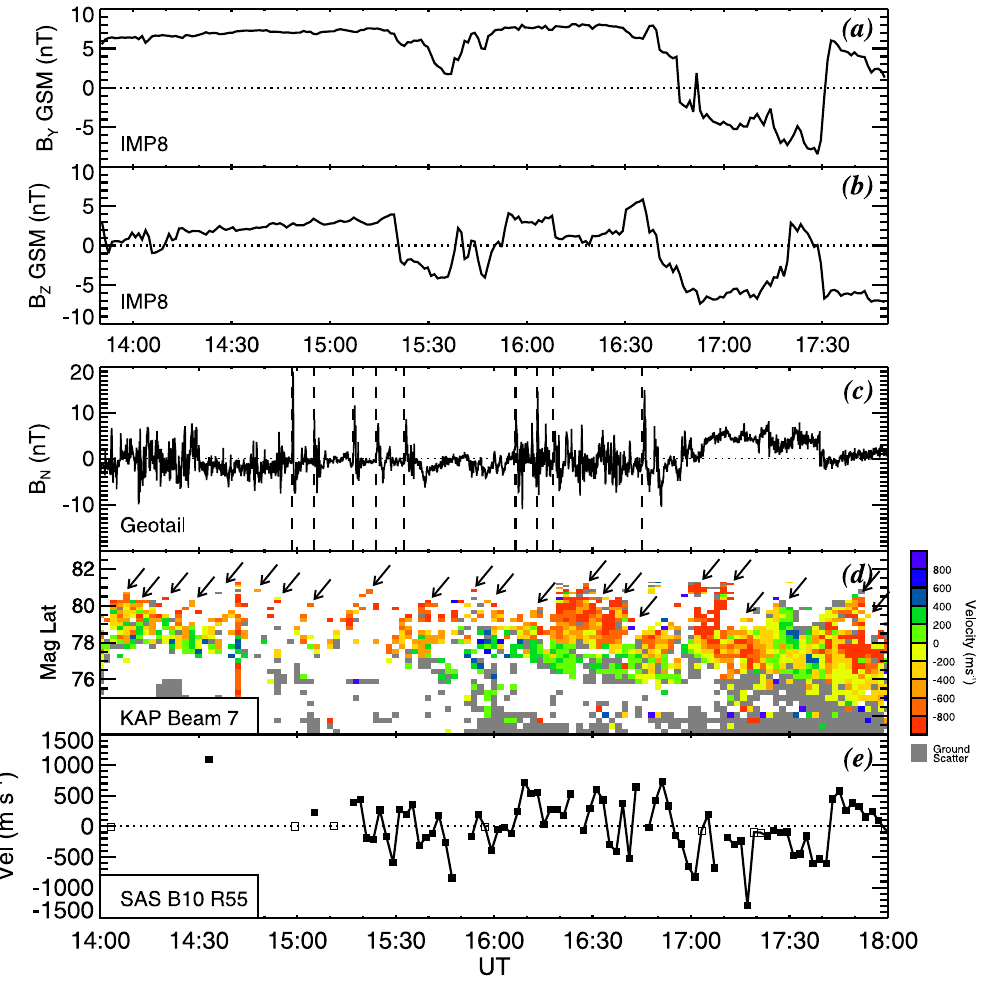
Fig. 9. Comparison of (a) and (b) the upstream IMF, (c) Geotail FTEs, and ionospheric convection velocities observed by (d) beam 9 at range 49 of the Kapuskasing and by (e) beam 10 at range 55 of the Saskatoon SuperDARN radars. The magnetic footprint of the Geotail spacecraft is located in the Saskatoon-Kapuskasing field of view in the prenoon